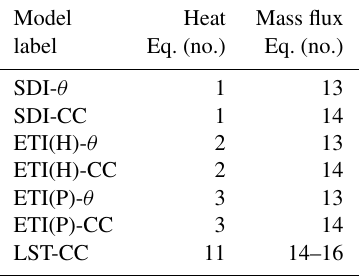
Table 3. Heat module and mass flux module combinations that we assess, described, respectively, in Sects. 2.1 and 2.2. In all cases the seven fixed module formulations are those presented in Table